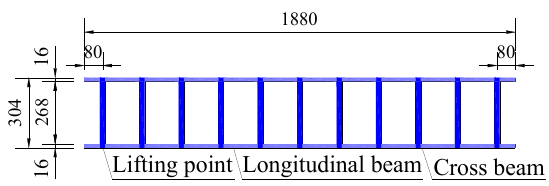
Figure 3. The test specimen of the bridge deck system (unit: cm).